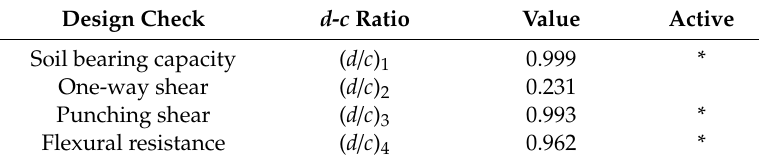
Table 7. Example 1: Demand–capacity ratios corresponding to the optimum design vector.